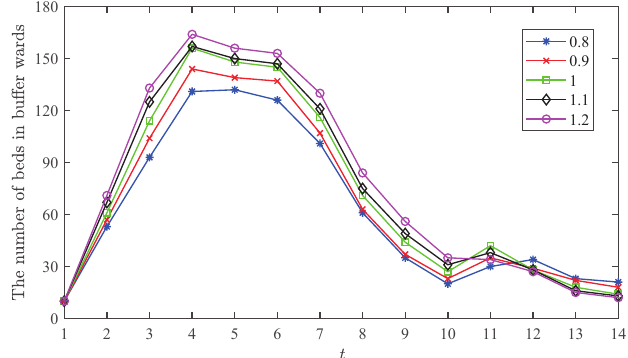
Figure 15. The number of beds in buffer wards in case